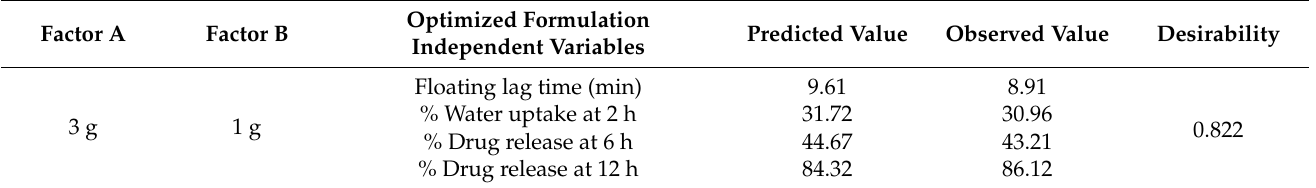
the software for the optimized